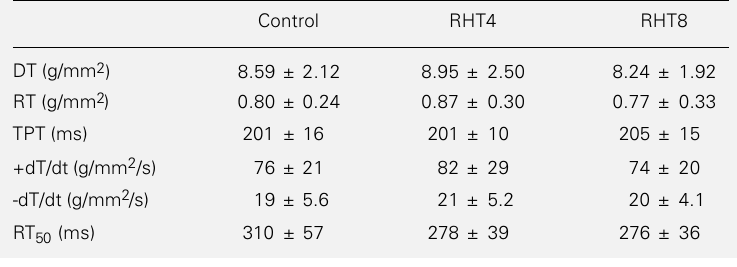
Table 2 - Isometric contraction data. Data are reported as means ± SD for N = 10. DT, Peak developed tension; RT, resting tension; TPT, time to peak tension; +dT/dt, maximum rate of tension development; -dT/dt, maximum rate of tension decline; RT 50 , time for tension to fall from peak to 50% of peak tension; RHT4, renovascular hypertension for 4 weeks; RHT8, renovascu- lar hypertension for 8 weeks (one-way analysis of variance and post hoc Tukey test).